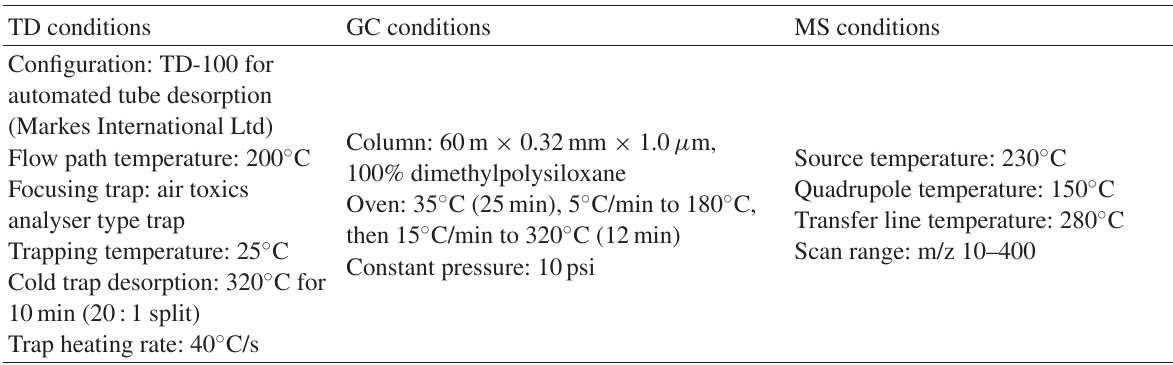
TABLE 1: Sampling and analytical